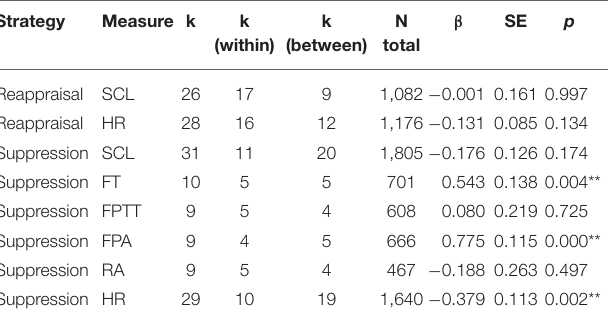
TABLE 5 | Moderator analyses on study design (within-subject design vs. between-subject design). Strategy